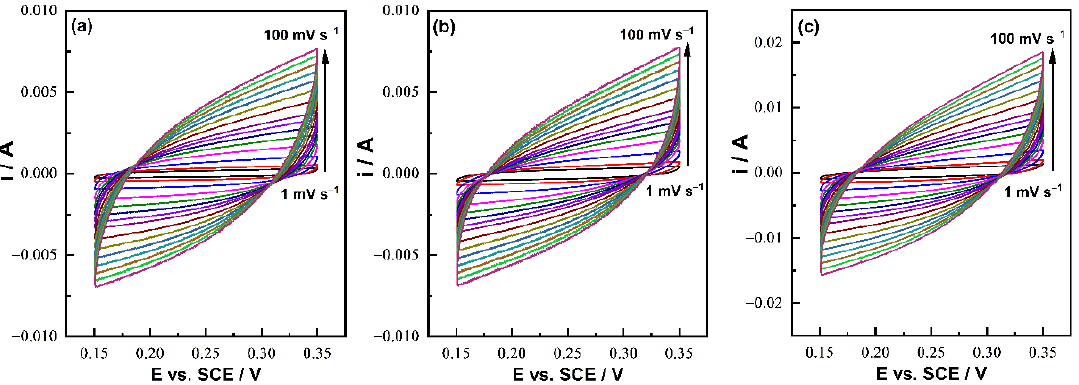
Figure 9. Effect of scan rate (1–100 mV s − 1 ) on the CV curves of ZnMn 2 O 4 spinel prepared for ( a ) 6 h, ( b ) 12 h, and ( c ) 18 h.